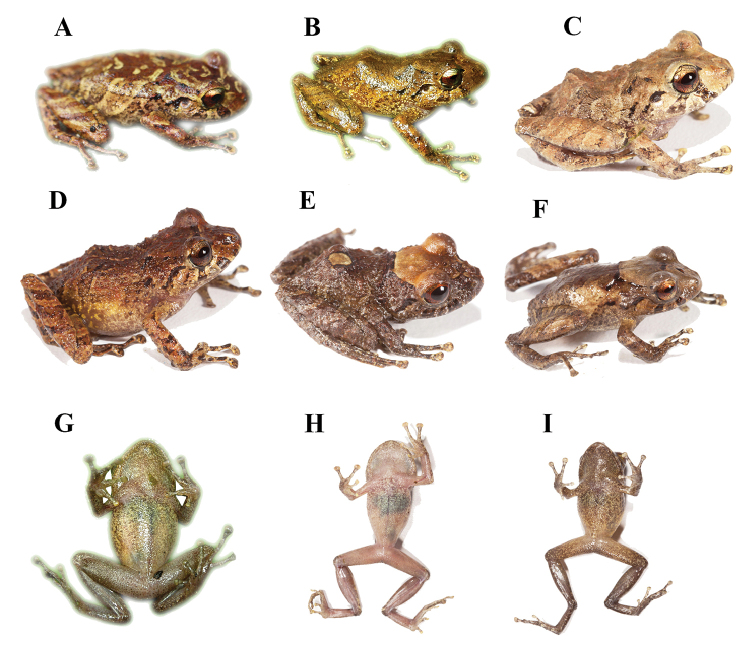
Coloration in life of Pristimantismallii sp. n. Dorsal view. AZSFQ 1305, SVL = 34.3 mm, adult female BDHMECN 5236, SVL = 30.9 mm, adult female CQCAZ 52473, SVL = 28.8 mm, holotype, adult female; Second line from left to right DQCAZ 52494, SVL = 29.3 mm, adult female EQCAZ 52512, SVL = 10.3 mm, subadult male FQCAZ 52474, SVL = 11.6 mm, adult male. Ventral view GDHMECN 5236, SVL = 30.9 mm, adult female HQCAZ 52473, SVL = 28.8 mm, holotype, adult female IQCAZ 52474, SVL = 11.6 mm, adult male. Pictures are not to scale.